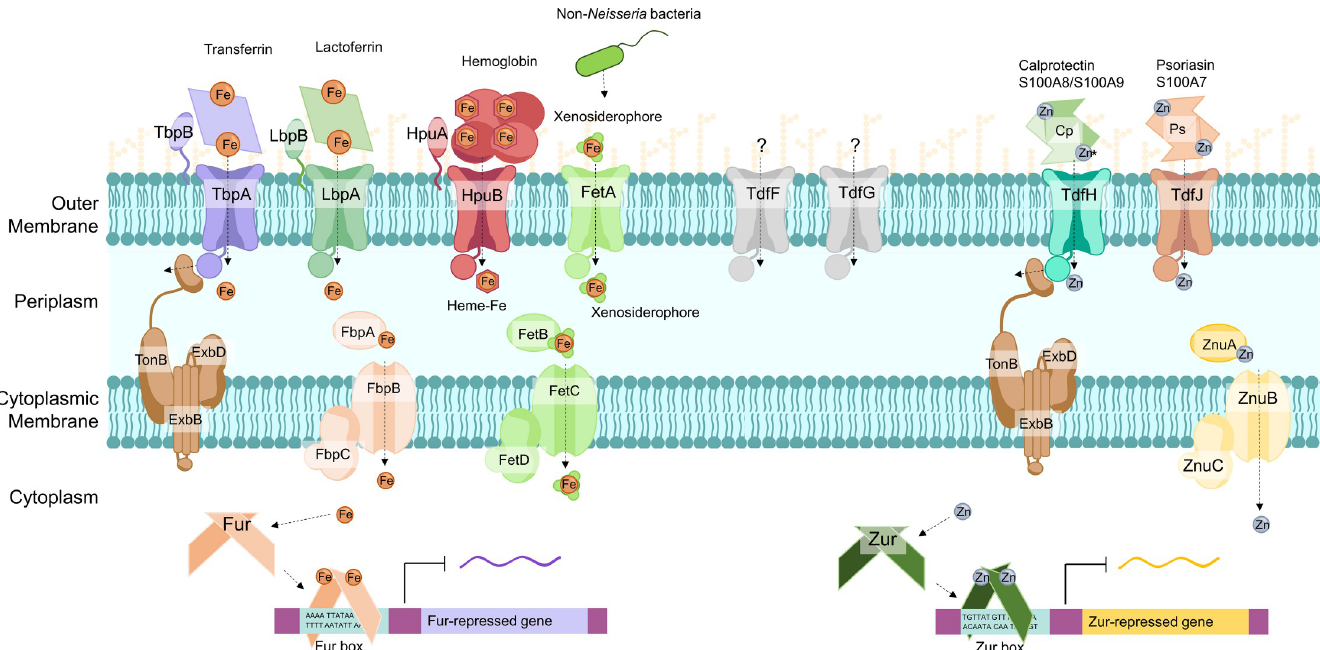
Fig 1. Metal acquisition systems expressed by N . gonorrhoeae in metal-limiting conditions. Outer membrane Tdfs produced by N . gonorrhoeae and their respective ligands, to date, are represented above in matching colors. Transporter–ligand interactions are described in the text. Metal ions are represented as spheres and labeled as Fe for iron and Zn for zinc. Zn � represents Zn and other divalent metals that bind at calprotectin’s His 6 site. The TonB system energizes Tdfs to internalize metal ions by moving the occluding plug domain (periplasmic circle attached to each transporter). ABC metal transport systems associated with Tdfs are found in the periplasm and the cytosolic membrane. Cytoplasmic metalloregulators Fur and Zur bind iron and zinc, respectively, and alter expression of metal acquisition genes.